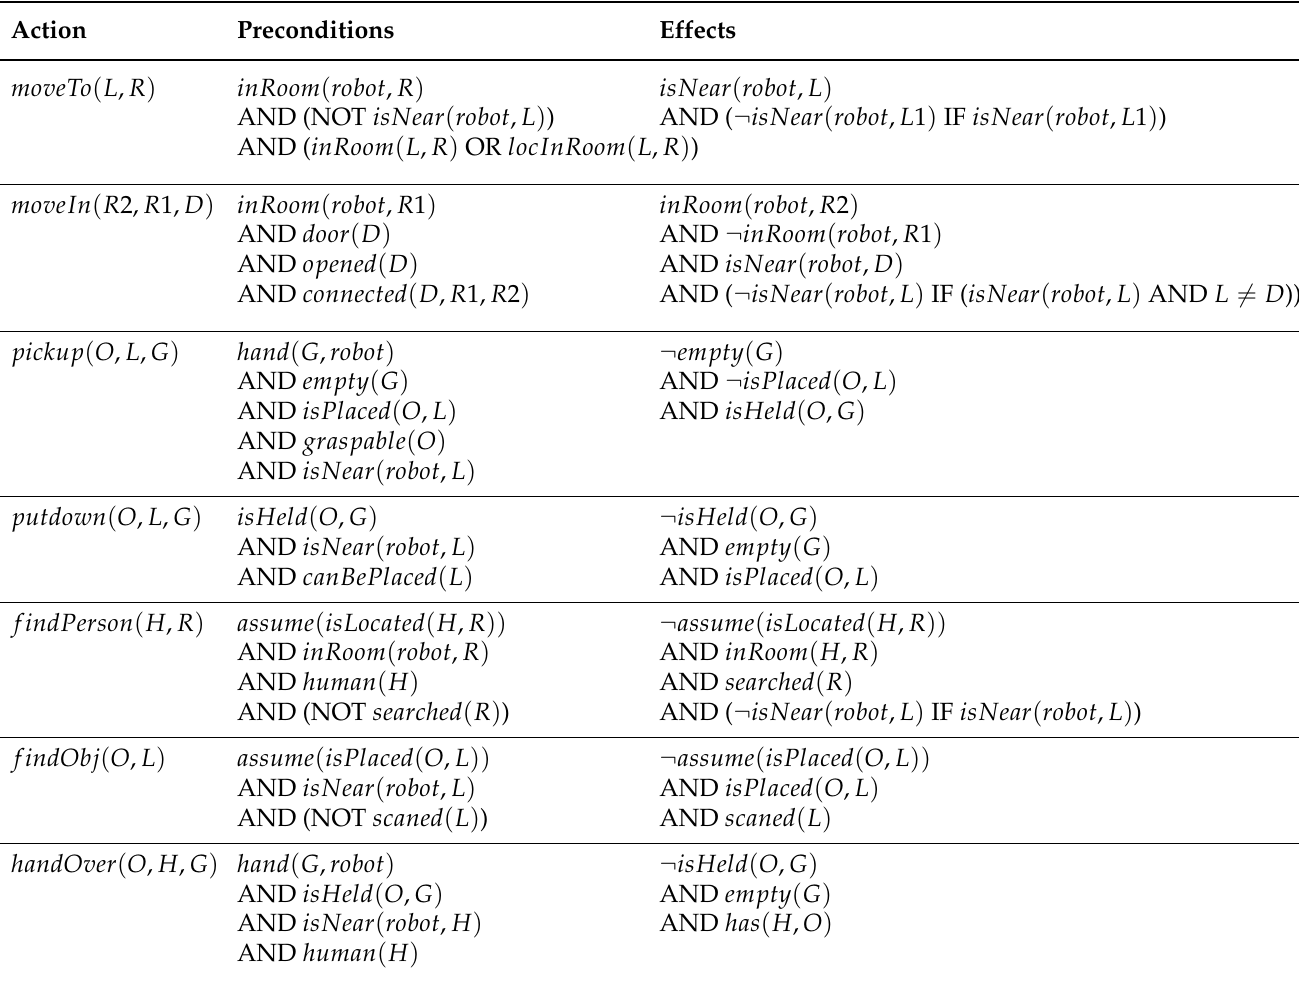
Table 3. Action, its preconditions and effects in our